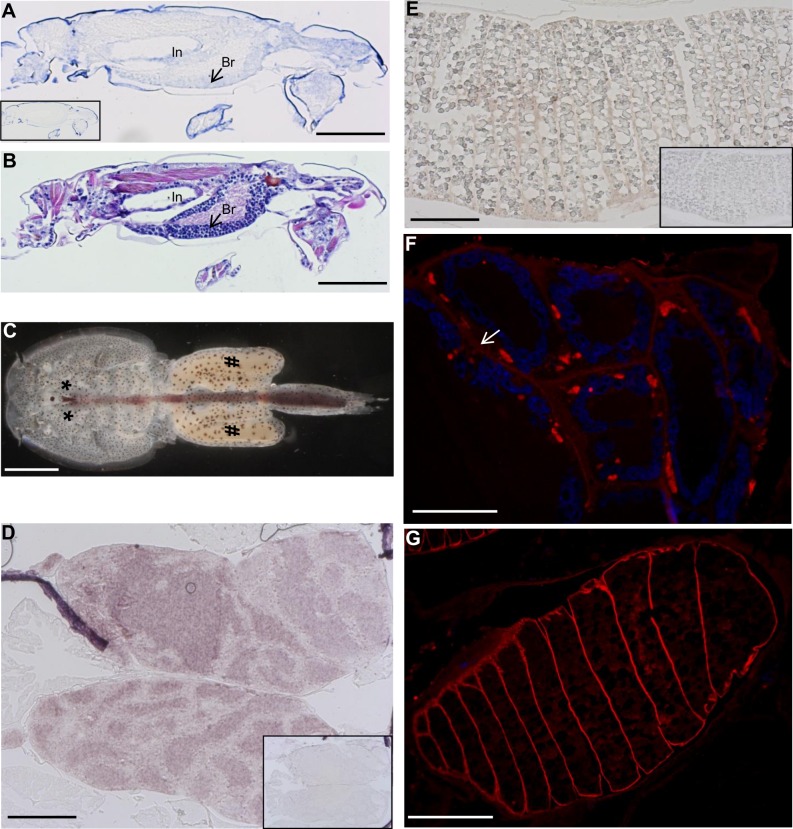
Localization of LsLpR mRNA and protein in the salmon lice.(A), (D) and (E) in situ hybridization. (A) Localization of the LsLpR transcripts in the intestine (In) and neuronal somata of the brain (Br) of copepodid. (B) Parallel slide of the copepodid stained with hematoxylin and erythrosine. (C) Dorsal view of an adult female without egg-strings. The asterisks (*) and hashtags (#) indicate the positions of the ovaries in the cephalothorax and mature vitellogenic oocytes in the genital segment of adult female louse respectively. (D) Localization of the LsLpR mRNA in the lumen of the ovarian tubules. (E) Localization of the LsLpR mRNA in the vitellogenic oocytes in the genital segment. No stain was seen in slides (small inserts) hybridized with sense RNA probe. (F) and (G) immunofluorescence with anti LpR. (F) Distribution of LsLpR protein was found in elongated structures, at the inner side of the tubular membrane (white arrow) together with the nuclei of the oocytes (nuclei were stained blue with DAPI). (G) Distribution of the LsLpR protein in the outer membrane of the vitellogenic oocytes. Scale bars indicate (A-B, E) 200 μm, (C) 1 mm, (D and G) 100 μm, (F) 50 μm.